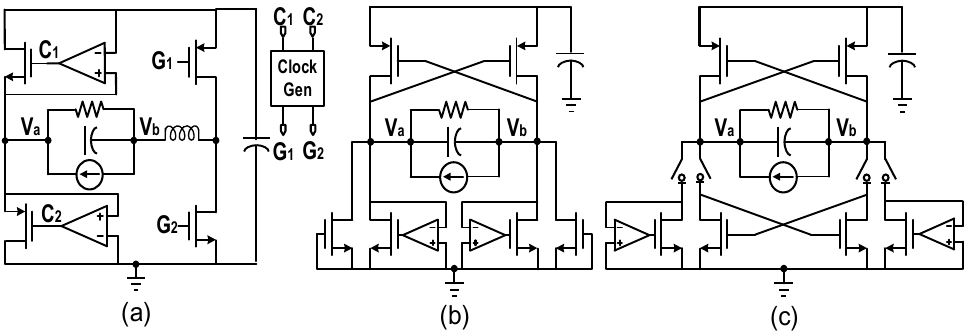
Figure 9. Structure diagrams of ( a ) active rectifier for the automatic control of voltage flipping ( b ) start-up optimized active rectifier ( c ) dual-mode active rectifier.